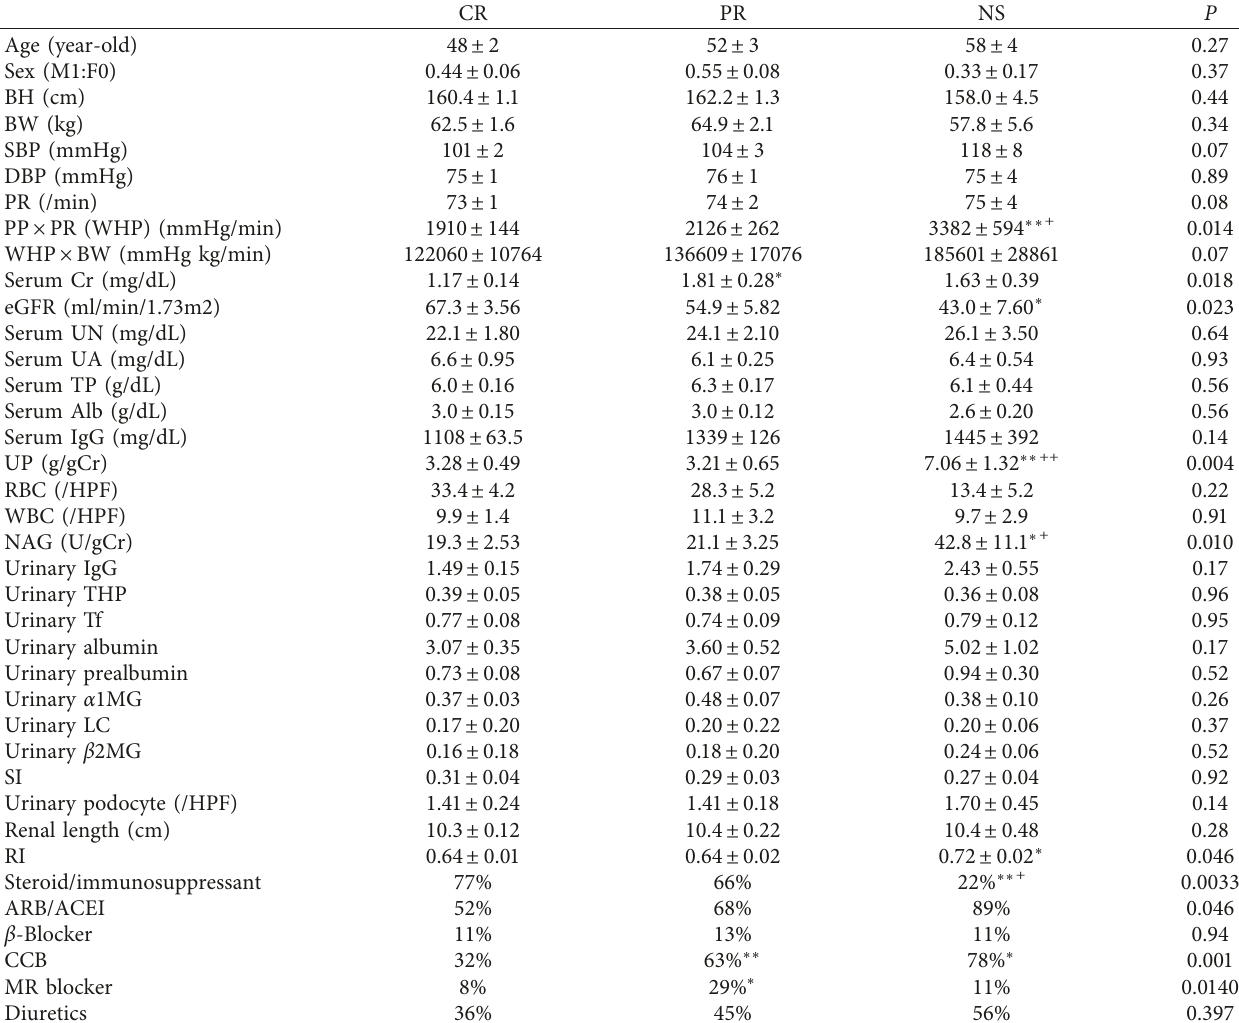
Table 4: Physiological data at the time of the renal biopsy according to the response of proteinuria. CR